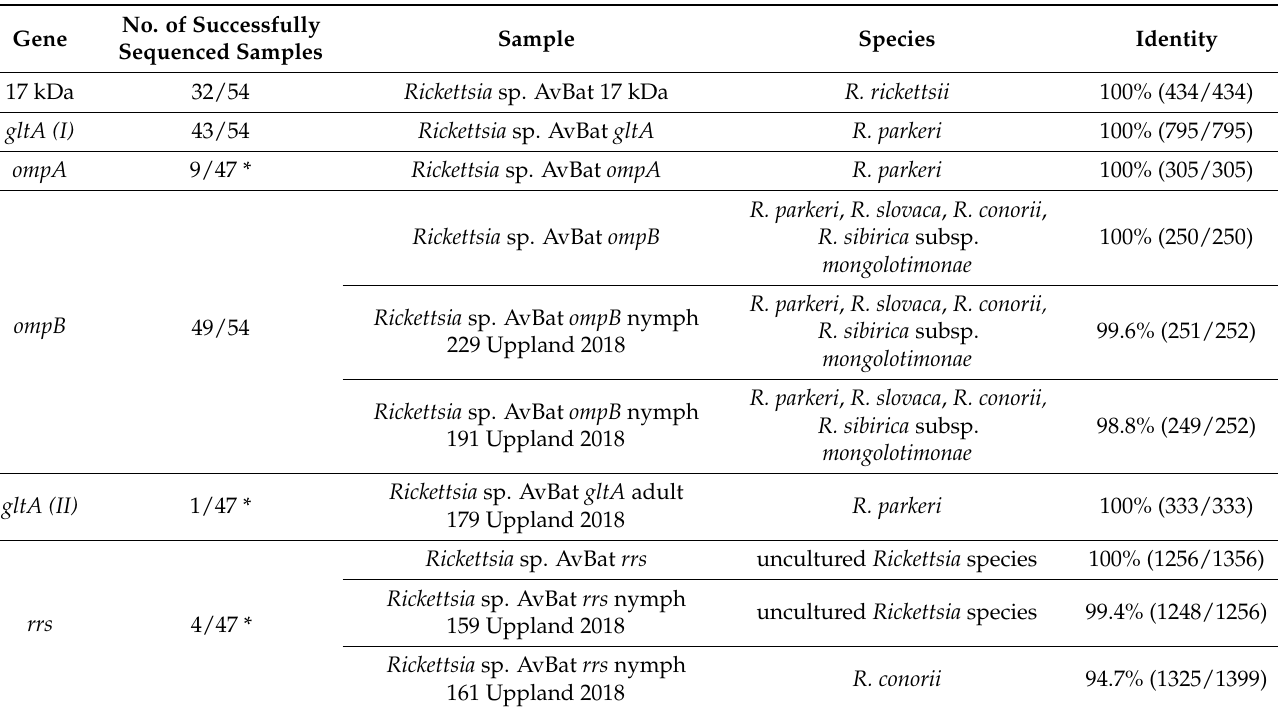
Table 4. Number of specimens with successful amplification of Rickettsia gene targets by conventional PCR assays. The sequences obtained from the amplification of the 17 kDa and gltA (I) genes have been used for phylogenetic